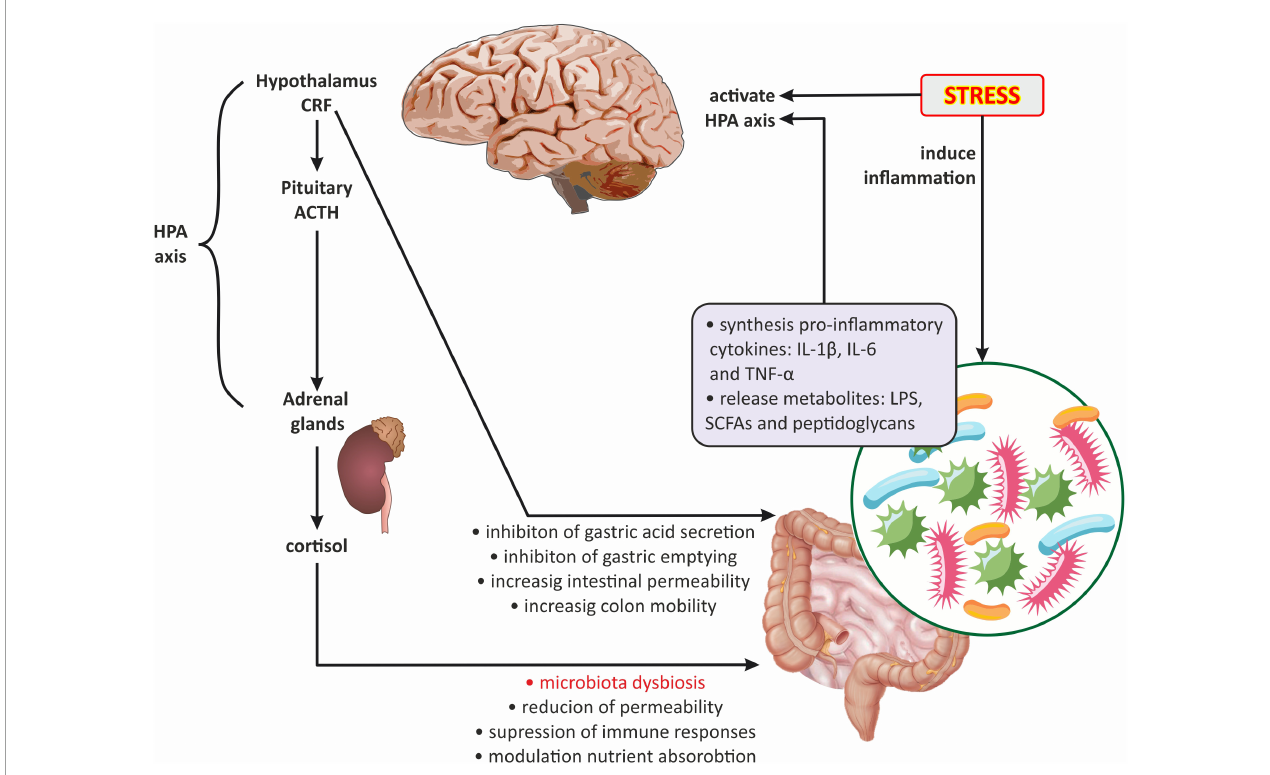
FIGURE4 The role of the hypothalamic-pituitary-adrenal axis in gut microbiota-brain communications. ACTH, adrenocorticotropic hormone; CRF, corticotropin-releasing factor; HPA axis, hypothalamic-pituitary-adrenal axis; IL-1 β , interleukin-1 beta; IL-6, interleukin 6; LPS, lipopolysaccharide; SCFAs, short-chain fatty acids; TNF α , tumor necrosis factor α .